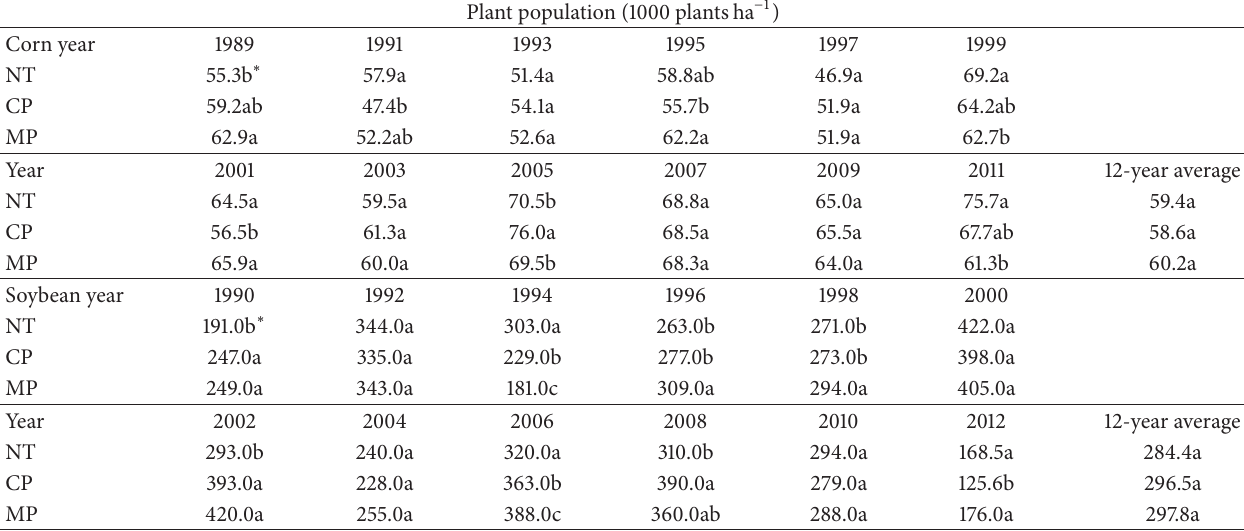
Table 3: Effect of different tillage treatments on the corn and soybean populations during 1989–2012 at Dixon Springs.